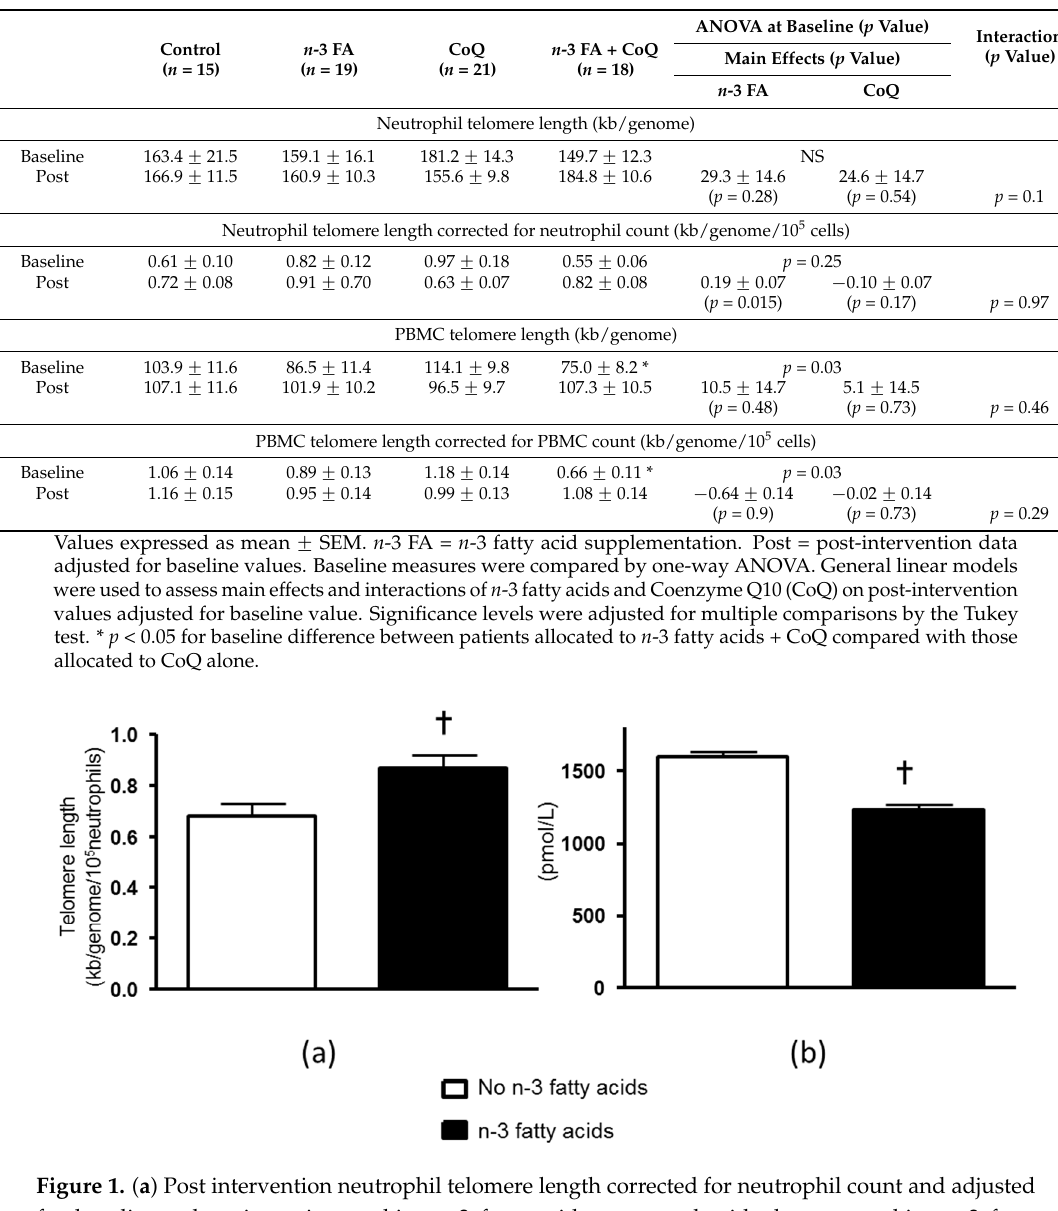
Table 1. Neutrophil and peripheral blood mononuclear cells (PBMC) telomere length before and after correction for cell counts at baseline and after 8 weeks intervention.